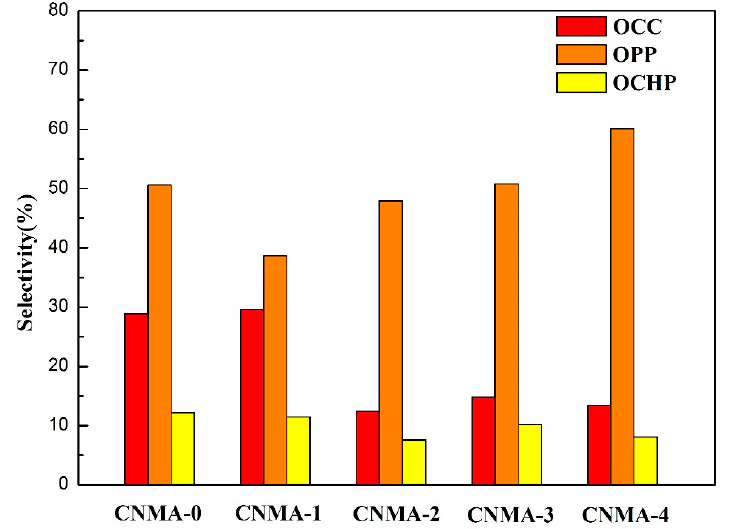
Figure 9. The selectivity for three types of main products for all samples after a reaction time of 5 h. (OPP: O-phenylphenol, OCC: O-cyclohexylcyclohexanone, OCHP: O-cyclohexylphenol).